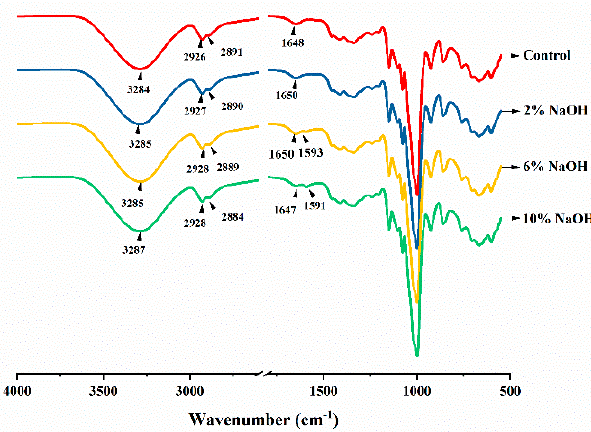
Figure 6. FTIR spectra of HAS films treated with different concentrations of NaOH. The oxidization of HAS during extrusion occurred in the HAS film with 6% NaOH, forming a